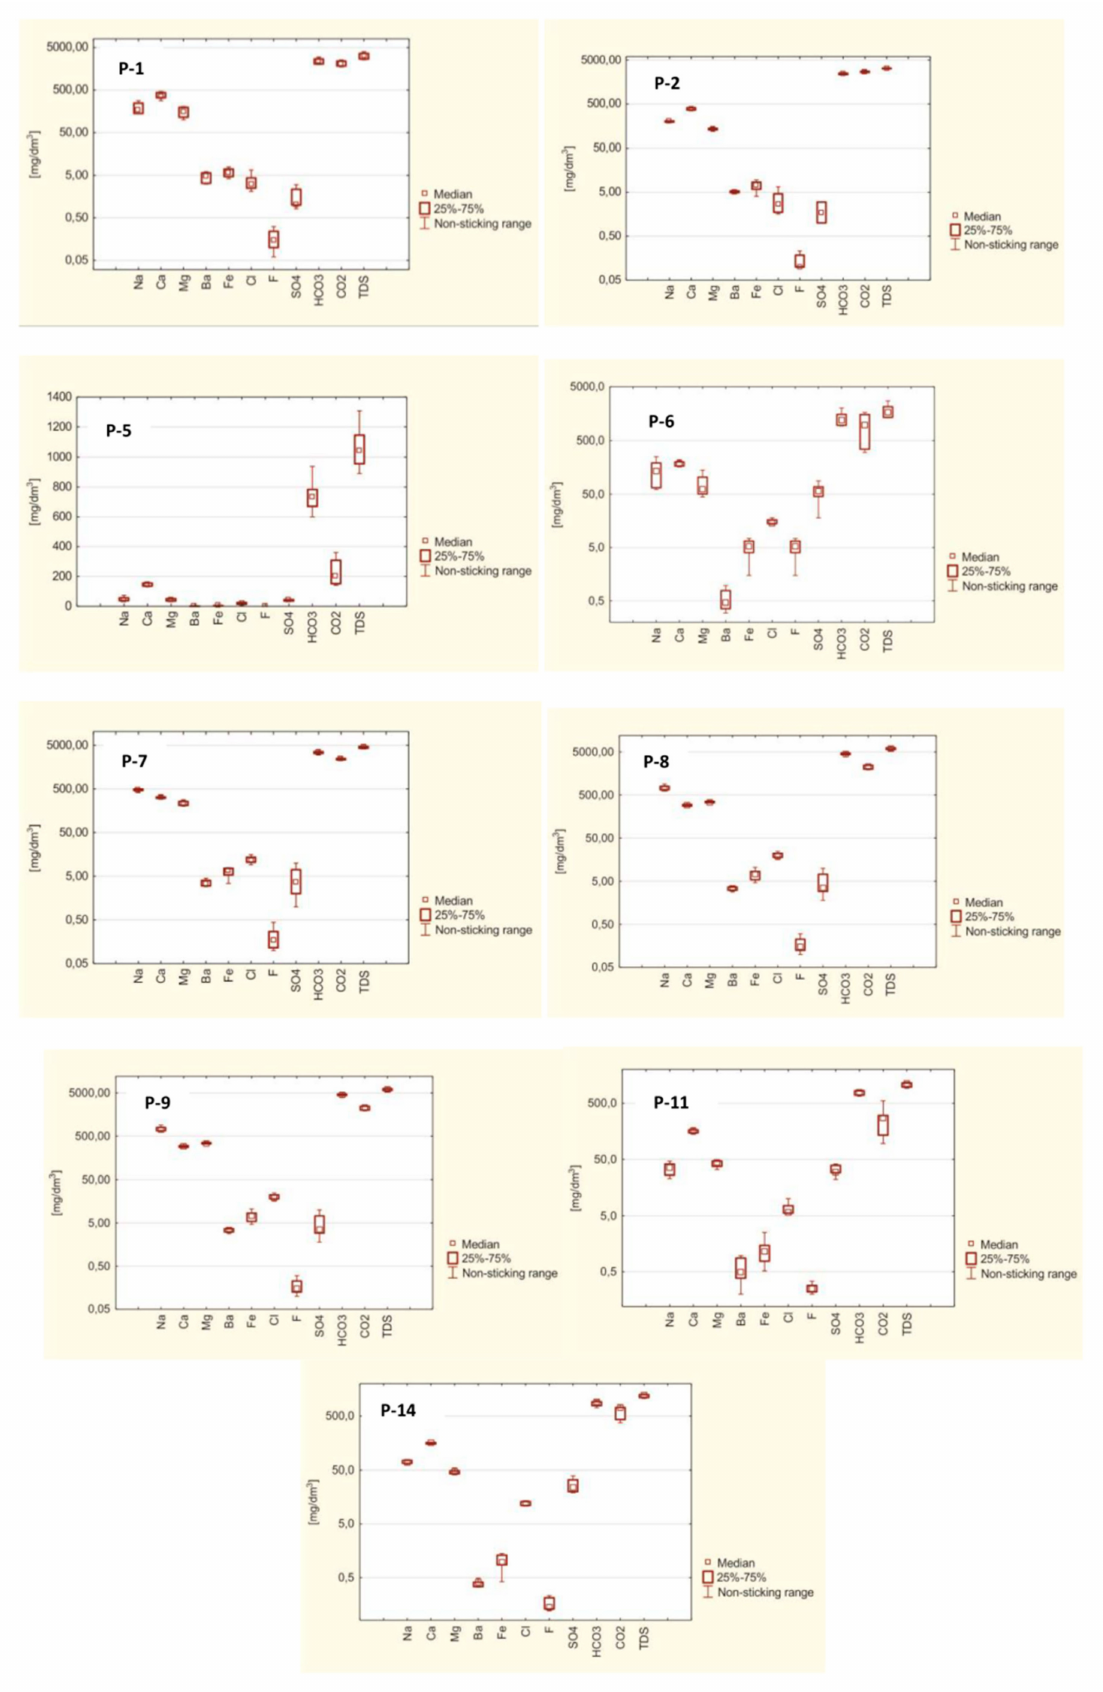
Figure 9. Characteristic values of selected ions in water from